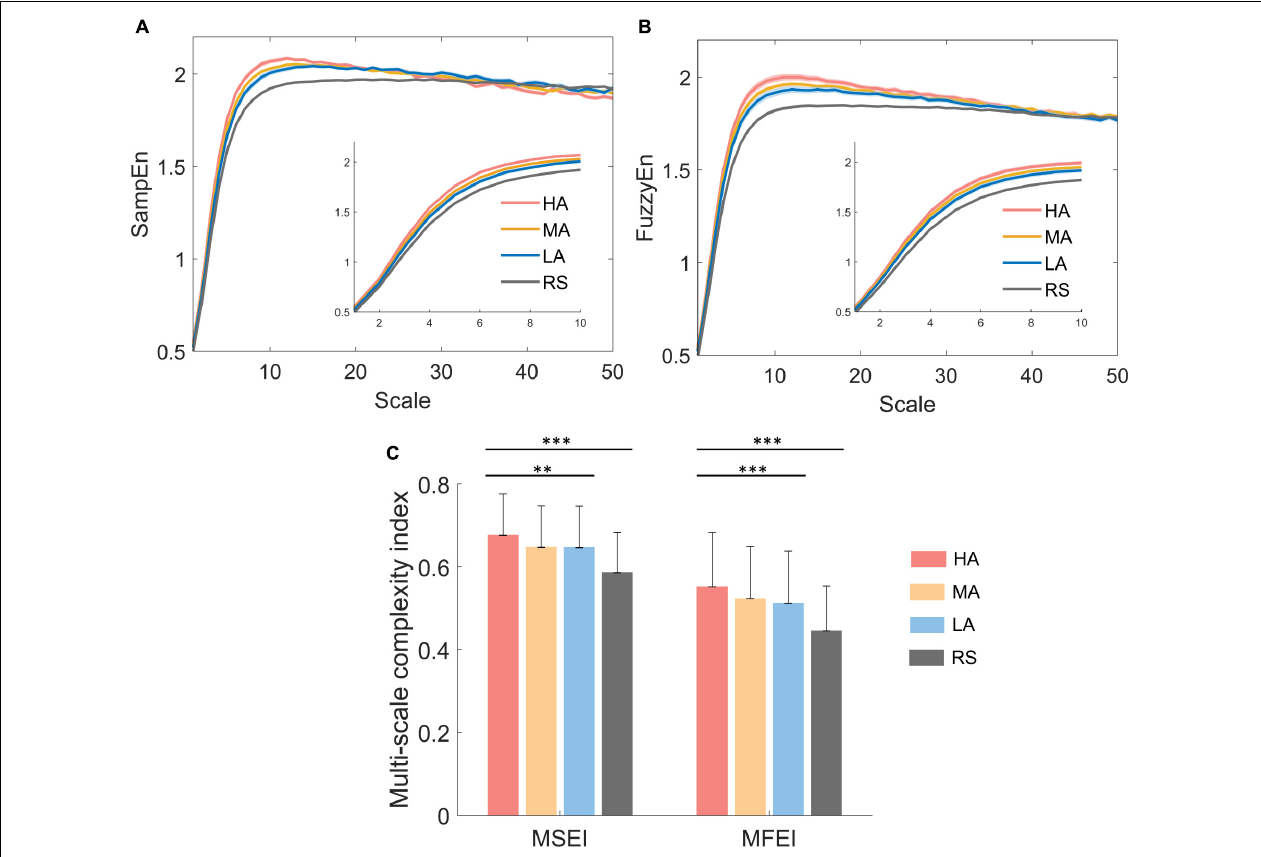
FIGURE 5 | Representative results of multiscale complexity analysis on electrodes F4. (A) The averaged multiscale sample entropy curves and (B) averaged multiscale fuzzy entropy curves of four attention states for 42 subjects, and the shadow represents SE. (C) Group differences between MSEI and MFEI among